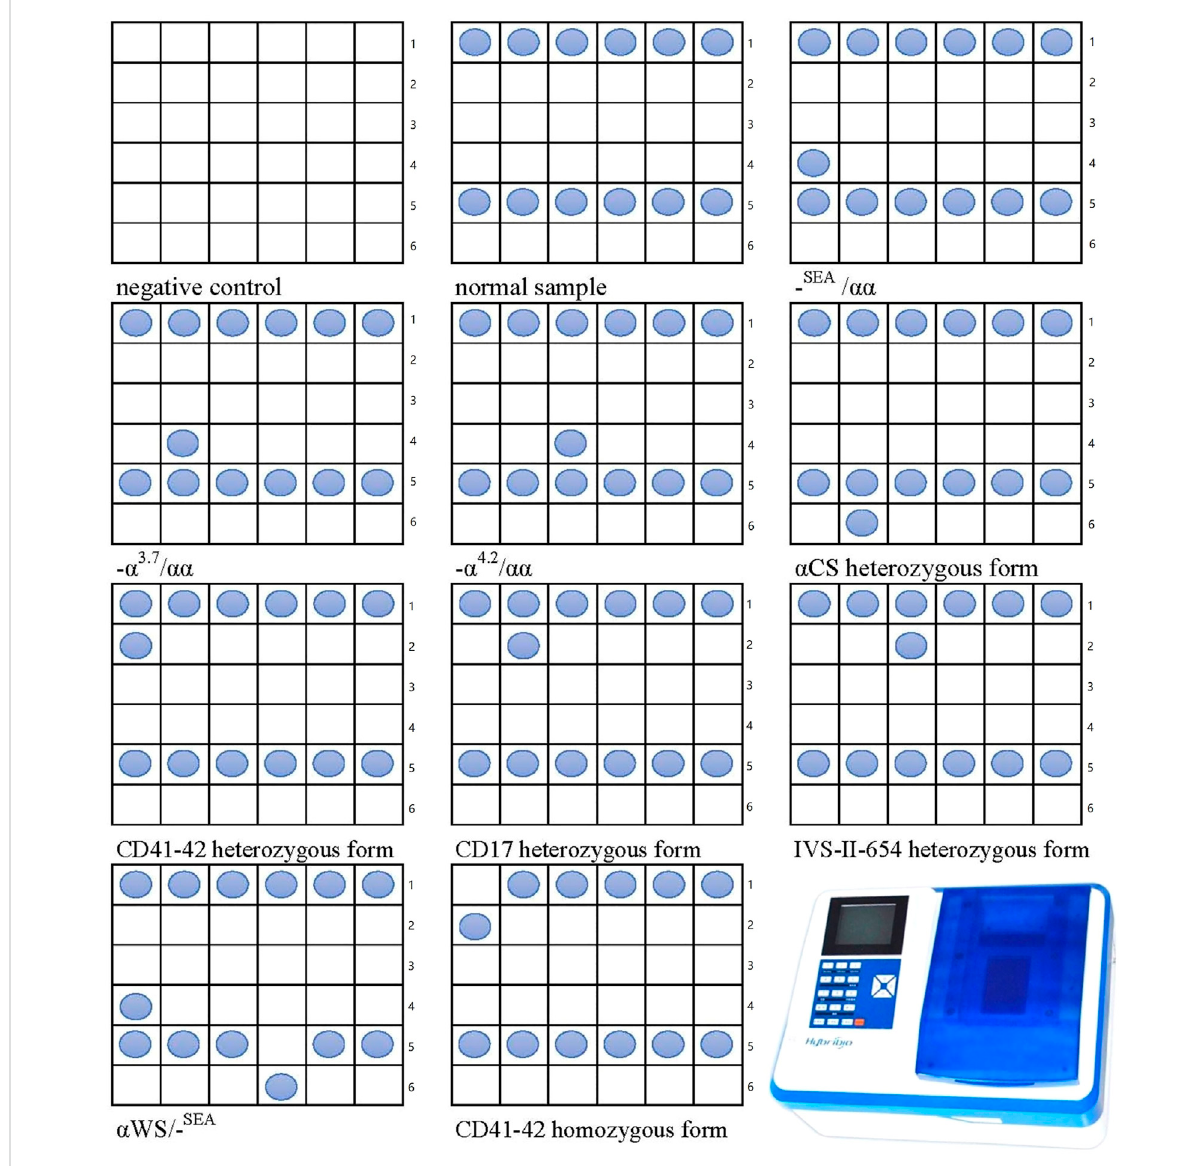
FIGURE 1 The Nucleotide template in each cell and the establishment of the genotyping of thalassemia using fl ow-through hybridization and gene chip. Line 1:41 – 42N, 17N, 654N, 71 – 72N, − 28N, β EN; line 2: 41 – 42M, 17M, 654M, 71 – 72M, -28M, β EM; line 3: 43M, 14 – 15M, − 30M, − 32M, − 29M, CapM;line4:SEA, α 3.7, α 4.2,31M,IVS Ⅰ -5M,IntM; line5:NP,CSN,QSN, WSN,IVS Ⅰ -1N,27 – 28N;line6:blank,CSM,QSM,WSM,IVS Ⅰ -1M.N,normal;M,